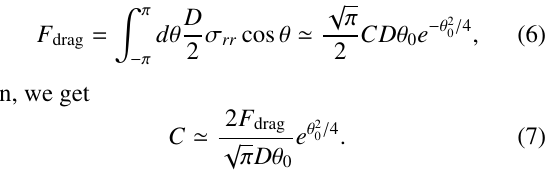
Figure 5. Stress fields of (a) σ xx and (b) σ x y around the object for D = 10 d , ϕ = 0 . 80, and F drag = 1 . 6 × 10 − 2 k n d , where we ≡ σ have introduced σ ∗ αβ / k n . The green and black solid lines αβ represent the contours ((a) 5 . 0 × 10 − 4 and 1 . 0 × 10 − 3 , (b) ± 1 . 0 × 10 − 4 and ± 2 . 0 × 10 − 4 ) obtained from the simulation (4) and the Airy stress function (11),